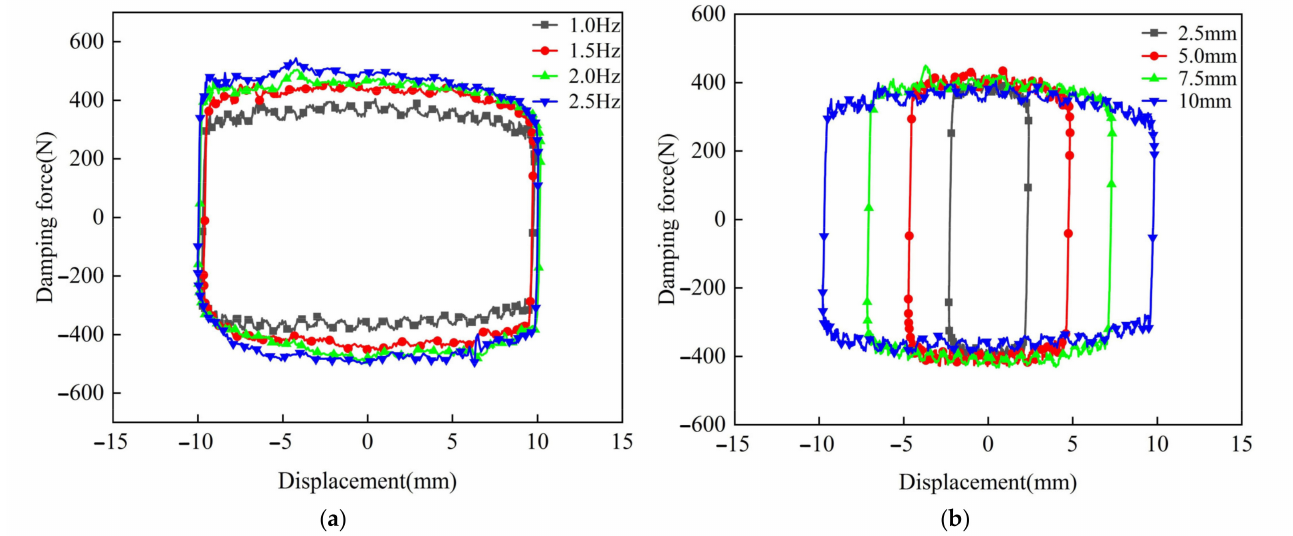
Figure 16. Relationship of force and displacement under different sinusoidal excitation experimental conditions. ( a ) Force-displacement curves at different frequency experimental conditions. ( b ) Force-displacement curves under different amplitude experimental conditions.